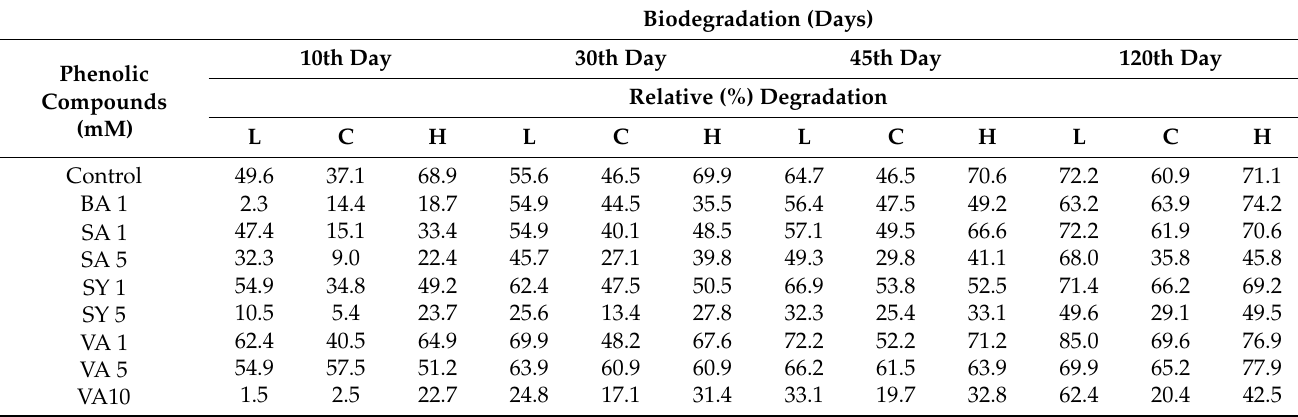
Table 2. Percentage of the chemical composition of oil palm wood (with and without treatment) degraded by G. boninense at various time